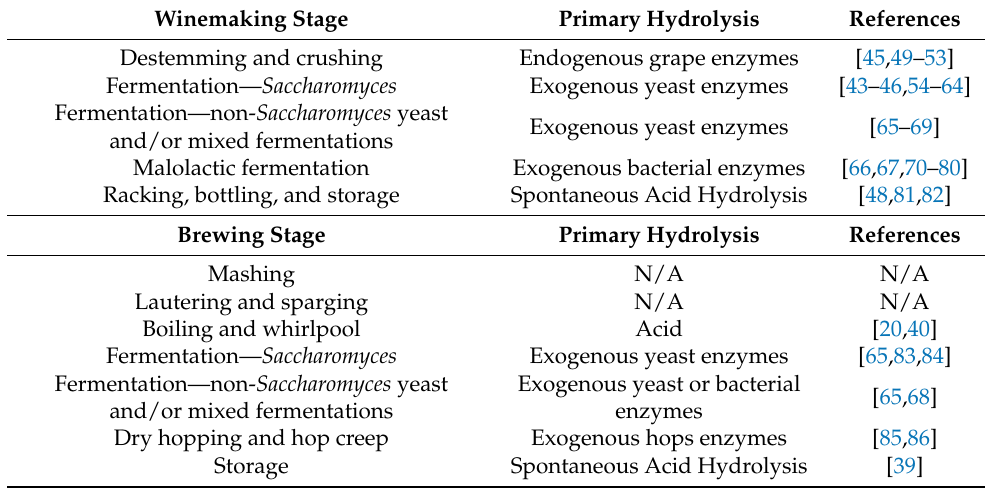
Table 1. Hydrolytic outline of the winemaking process and the brewing